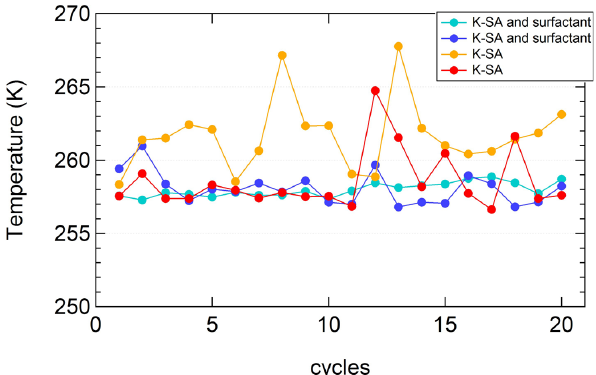
Fig. 7. Bulk measurements of freezing temperature for 5wt% K-SA suspensions mixed with lanolin (light and dark blue) and pure K-SA suspensions (red and orange). The median of the values shown here has been termed T best med